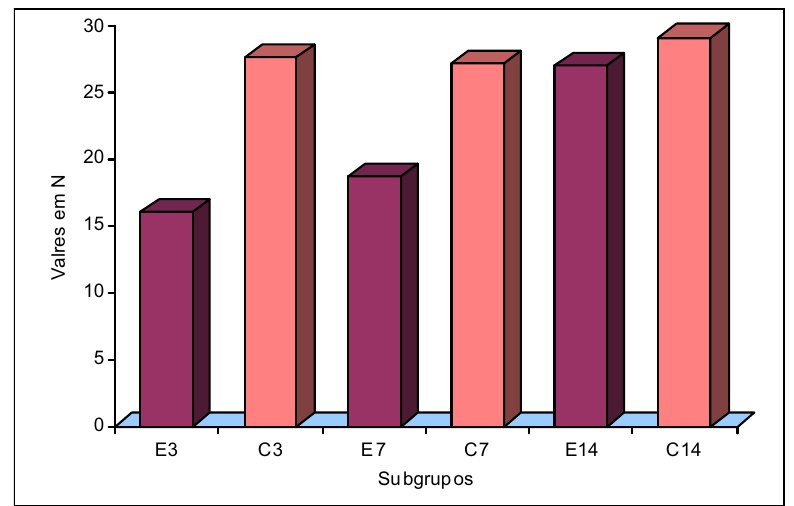
FIGURE 3 - Comparison of the tensile strength values in Newton obtained according to the experimental subgroup (E) composed of subgroups E3, E7, E14 and control group (C) composed of subgroups C3, C7 and